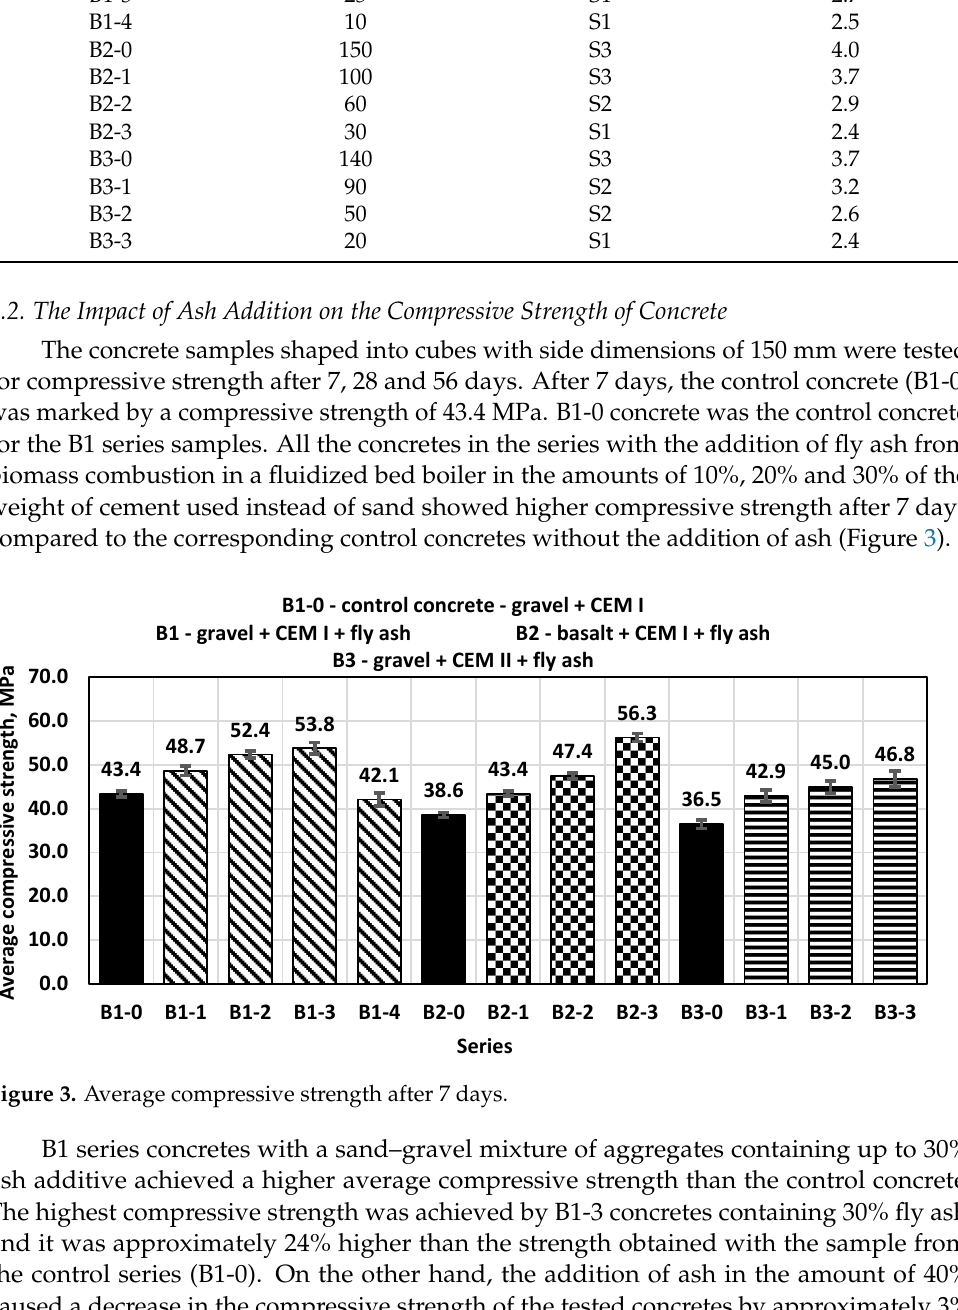
Figure 3. Average compressive strength after 7 days. B1 series concretes with a sand–gravel mixture of aggregates containing up to 30% ash additive achieved a higher average compressive strength than the control concrete. The highest compressive strength was achieved by B1-3 concretes containing 30% fly ash and it was approximately 24% higher than the strength obtained with the sample from the control series (B1-0). On the other hand, the addition of ash in the amount of 40% caused a decrease in the compressive strength of the tested concretes by approximately 3% compared to the control concrete. The compressive strength results for B2 series concretes with a basalt–sand mixture of aggregates and the addition of fly ash obtained after 7 days confirmed the tendency observed for the B1 series concretes. The increase in strength for the B2-3 series was 45% compared to the B2-0 control concrete. For concrete samples